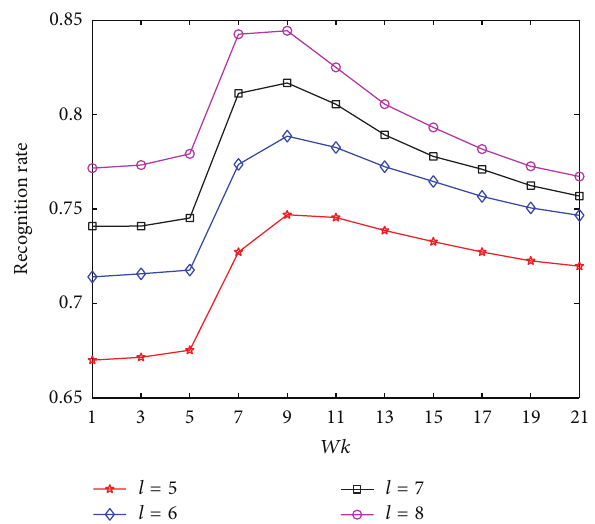
Figure 2: The average recognition rates of MNMDP versus 𝑊𝑘 on HRF.